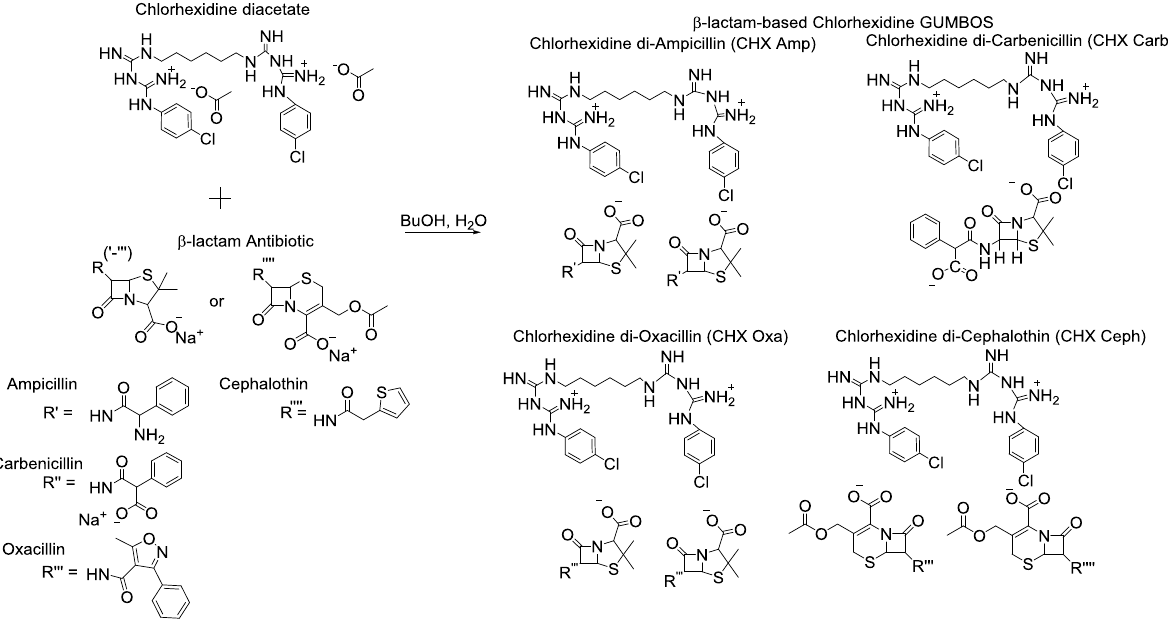
Figure 1. Structures of precursor ions and β-lactam-based chlorhexidine GUMBOS